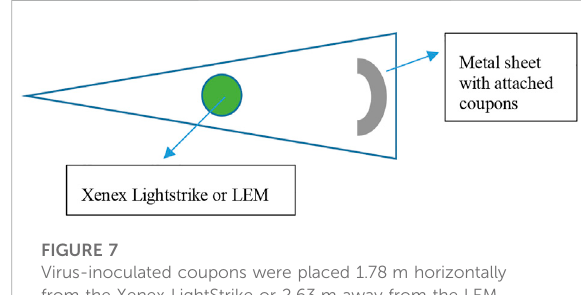
FIGURE 7 Virus-inoculated coupons were placed 1.78 m horizontally from the Xenex LightStrike or 2.63 m away from the